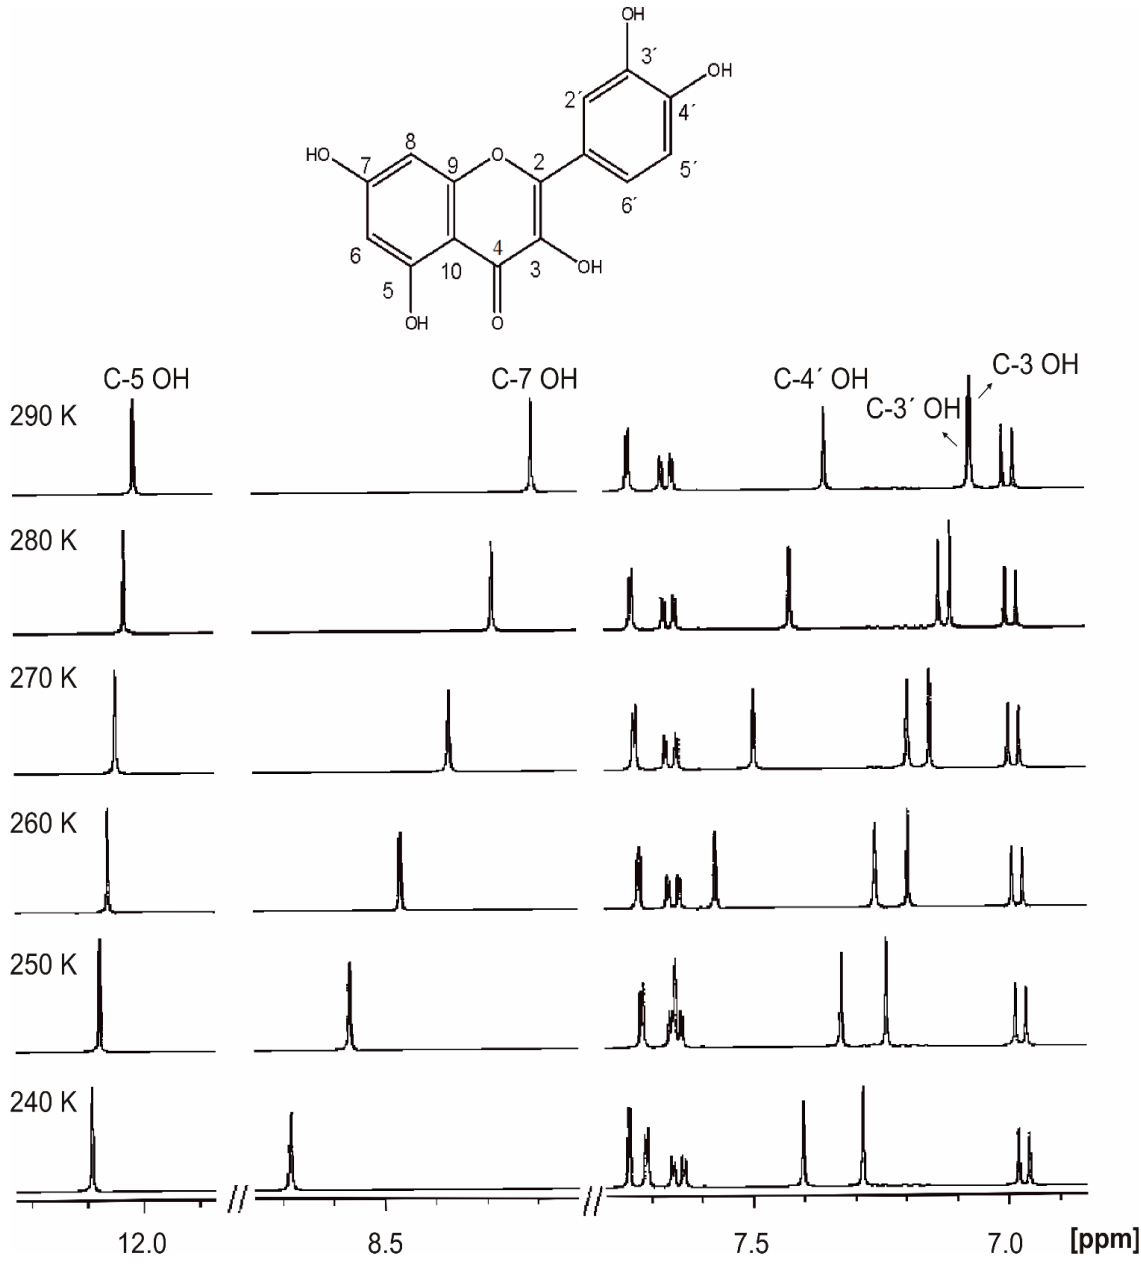
Figure 12. Variable temperature (400 MHz) 1 H-NMR spectra of quercetin in CD concentration 5 mM, with the presence of 2 μL picric acid, 8 mM in CD scans = 32, experimental time = 4 min). Reprinted with permission from [25].